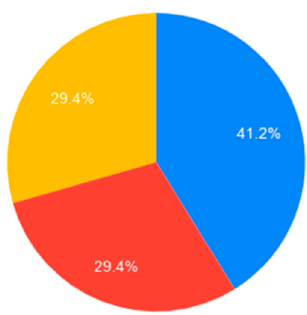
Figure 5. Would you be interested in monitoring the air quality in your production workspace?